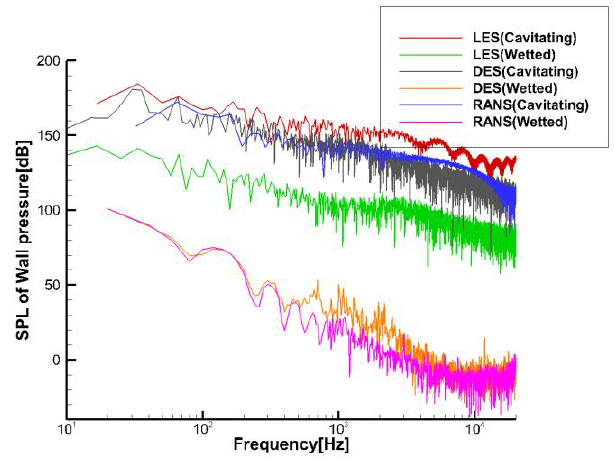
Figure 13. Comparison of LES, DES, and RANS models; SPL of wall pressure according to cavitating flow and wetted flow.